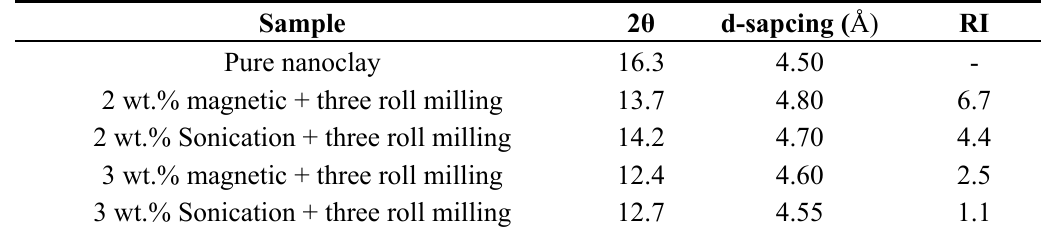
Table 4. Extracted X-ray diffraction parameters for the nanocomposites polymer